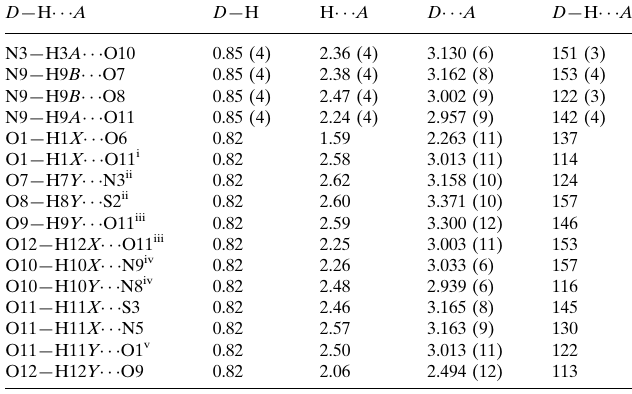
Hydrogen-bond geometry (A˚ , (cid:2)